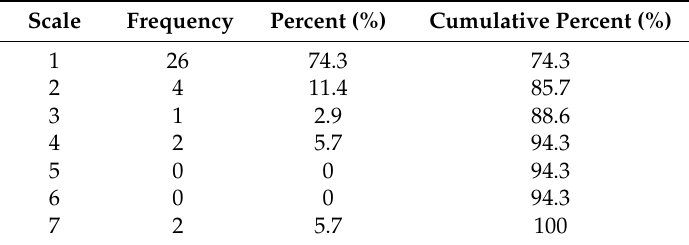
Table 1. The Finnish laying hen farmers’ ( n = 35) attitude towards beak trimming, on a scale from 1 ([I would] most definitely not) to 7 ([I would] most probably) use beak-trimmed hens if beak trimming were